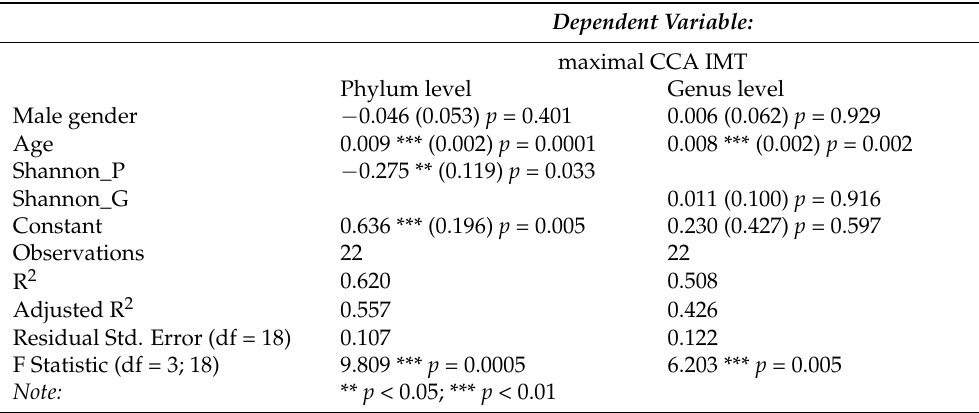
Table 2. Correlation of maximal CCA IMT and microbiome alpha diversity at 2 taxonomic levels.